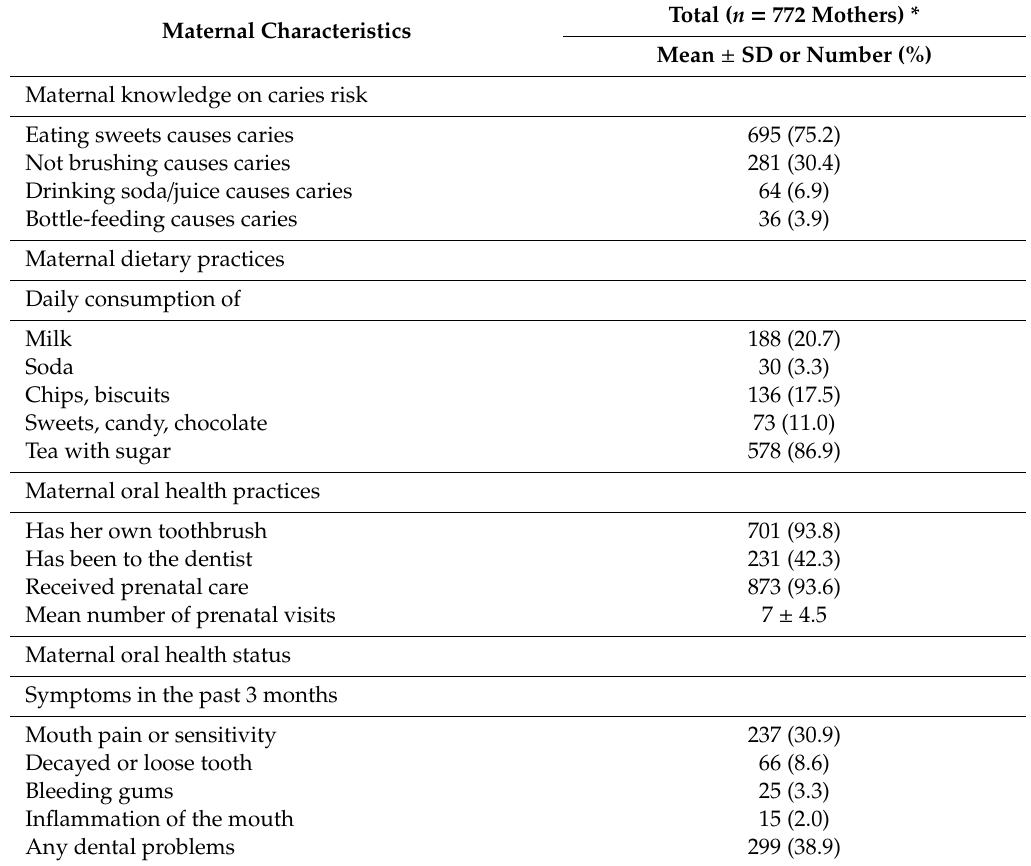
Table 2. Maternal Oral Health and Nutrition Knowledge, Practices, and